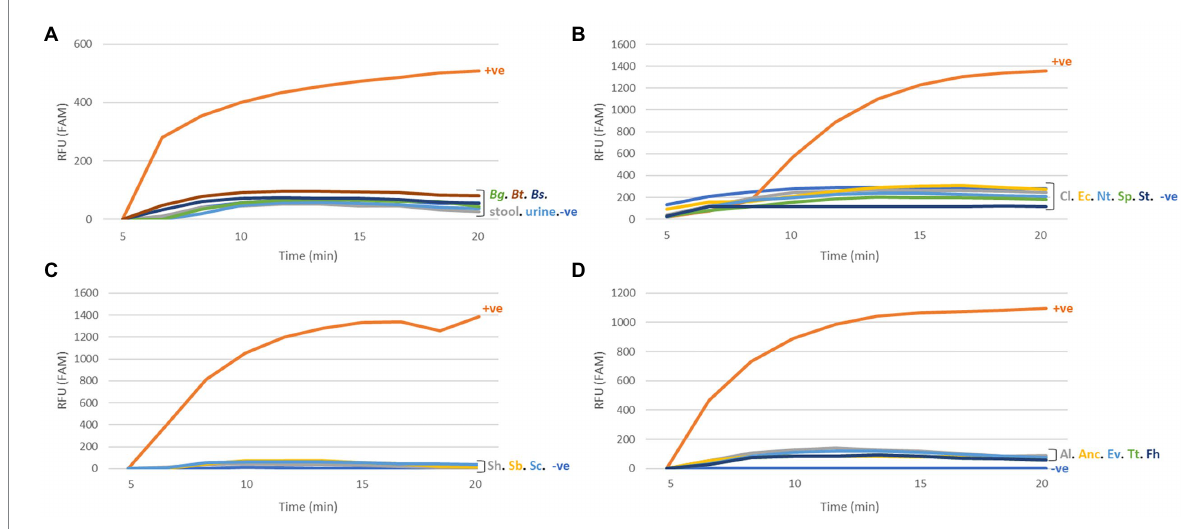
FIGURE 4 Specificity of the SmMIT-RPA. The assay was specific to Schistosoma mansoni with no cross-reactivity against (A) The host species; (B) Trematodes; (C) Schistosoma species; (D) Helminths of medical importance. All graphs are displayed with the background baseline fluorescence subtracted. Legend: RFU-relative fluorescence units; +ve-positive control (1 ng of S . mansoni gDNA); − ve-negative control (water); Bg, B . glabrata ; Bt, B . tenagophila ; Bs, B . straminea ; Cl, Clinostomidae; Ec, Echinostomatidae; Nt, Notocotylidae; Sp, Spirorchiidae; St, Strigeidae; Sh, S . haematobium ; Sb, S . bovis ; Sc, S . curassoni ; Al, A . lumbricoides ; Anc, Ancylostomidae; Ev, E . vermicularis ; Fh, F . hepatica ; and Tt, T . trichiura